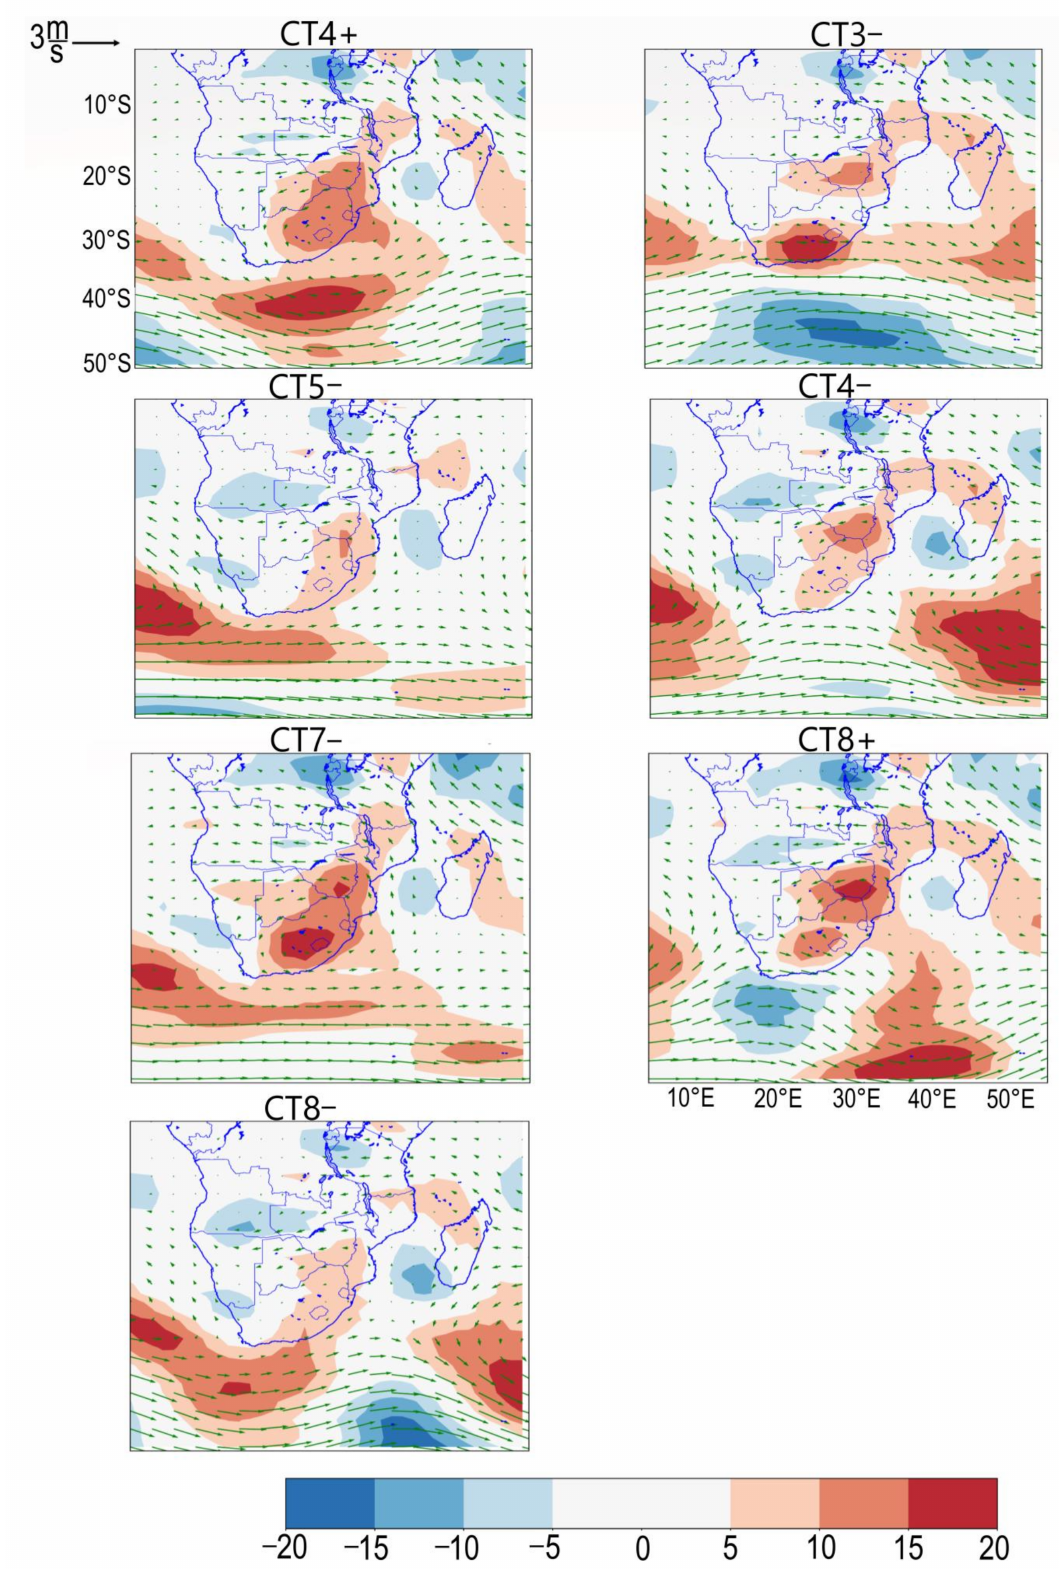
Figure 7. Composites of wind vector and relative vorticity at 850 hPa for the selected CTs. The scale of wind is given on top of the map. The color bar is the relative vorticity with the unit in 10 6 /s. Green vectors are wind. The dry (wet) patterns are in the left (right)